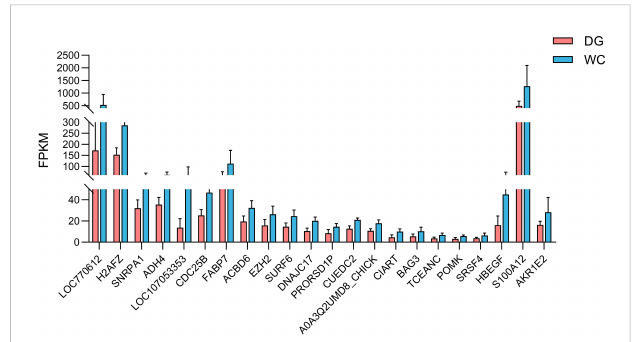
FIGURE 6 The expression levels of twenty-two intersecting genes of DEGs and hub genes in different modules. The default difference gene and the difference were not marked in the fi